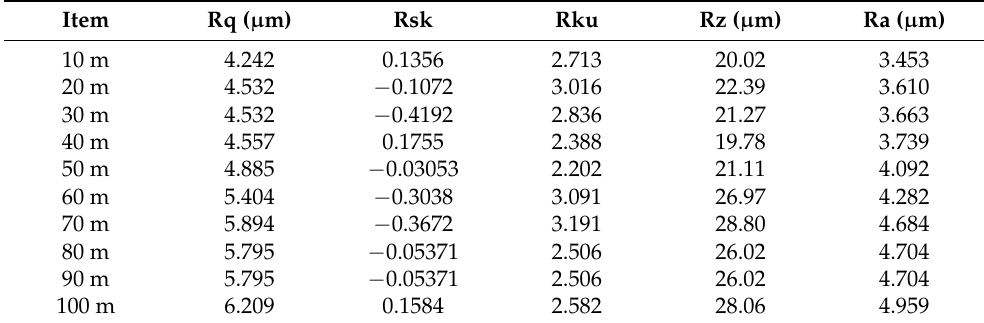
Table 3. The surface topography parameter